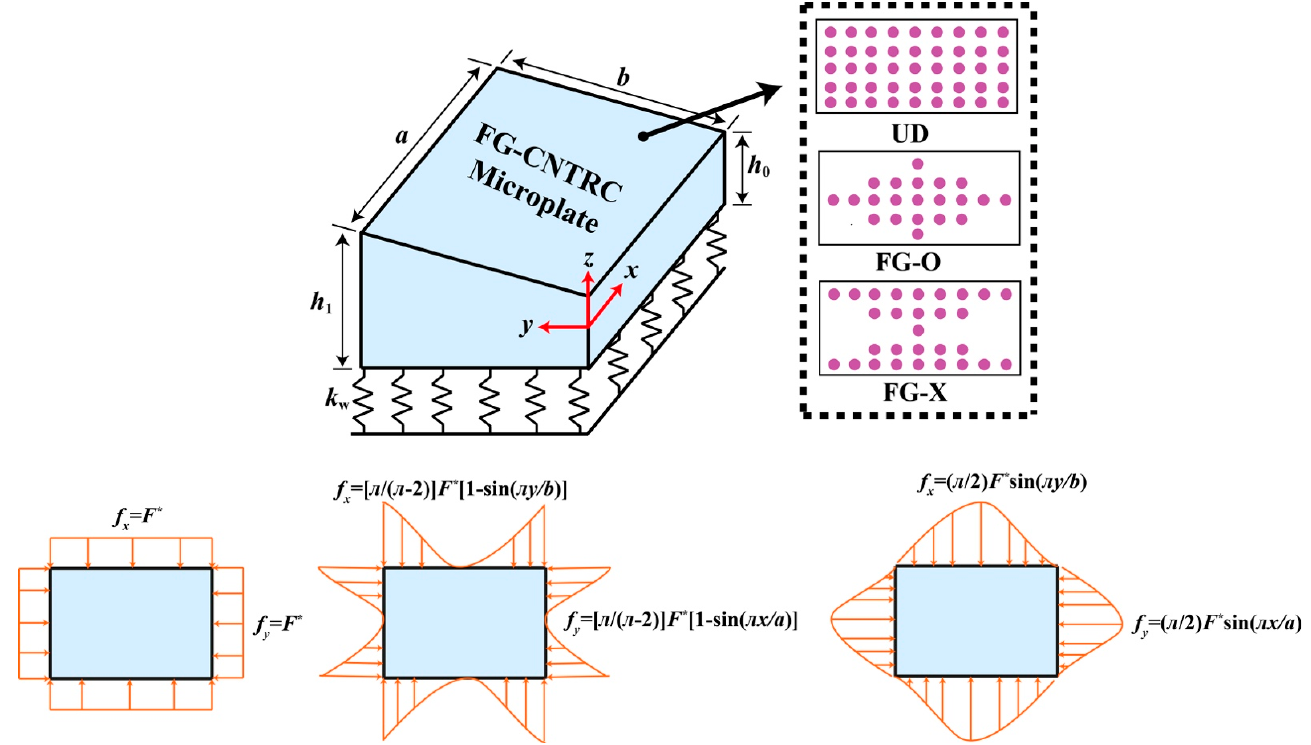
Figure 1. Configuration of an FG-CNTRC microplate resting on an elastic medium subjected to biaxial uniform and non-uniform edge compression loads.